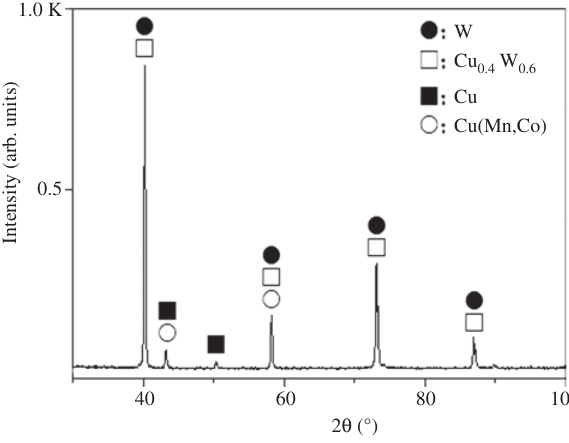
Figure 5: Element distribution near the interface of the W75-Cu/ W55-Cu brazed joint: (A) line scan location; (B) element distribution of Cu, W, Mn, and Co. Figure 6: XRD patterns of the W75-Cu/W55-Cu brazed